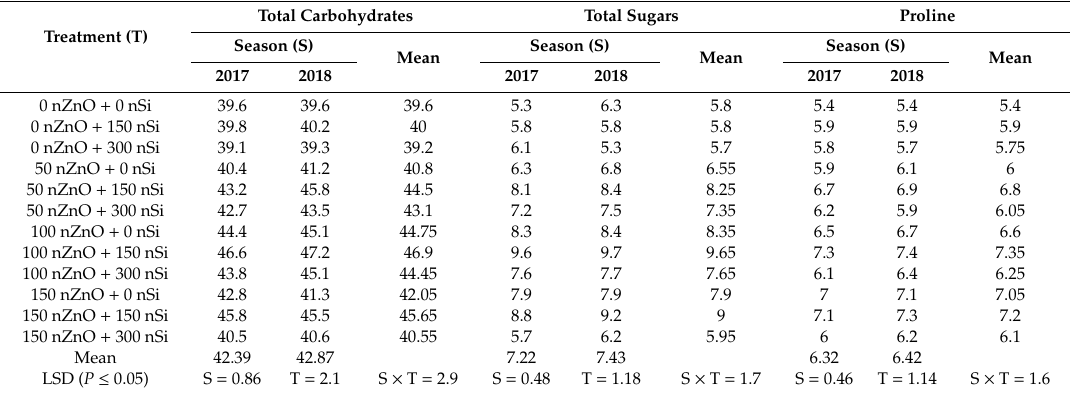
Table 4. E ff ect of foliar spray with ZnO and Si NPs (mg / L) on leaf total carbohydrates (mg / g dw), total sugars, and proline (mg / g fw) content of “Ewais” mango trees during the 2017 and 2018